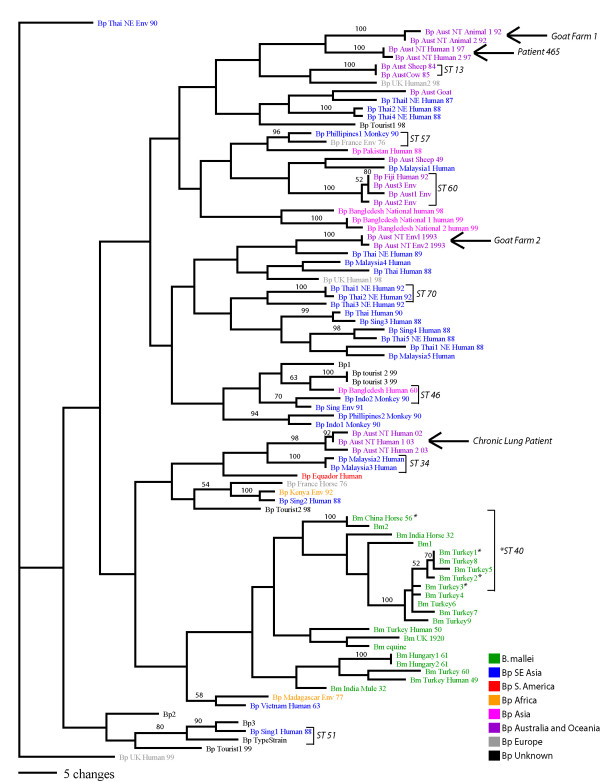
Arbitrarily rooted phylogram of 66 B. pseudomallei and 21 B. mallei isolates. Colors indicate the geographic area from which the isolates were collected. Arrows indicate isolates from patients or from a specific outbreak event. Isolates that had identical MLST genotypes are bracketed and the sequence type is given. * indicates which B. mallei isolates were available on the MLST database.